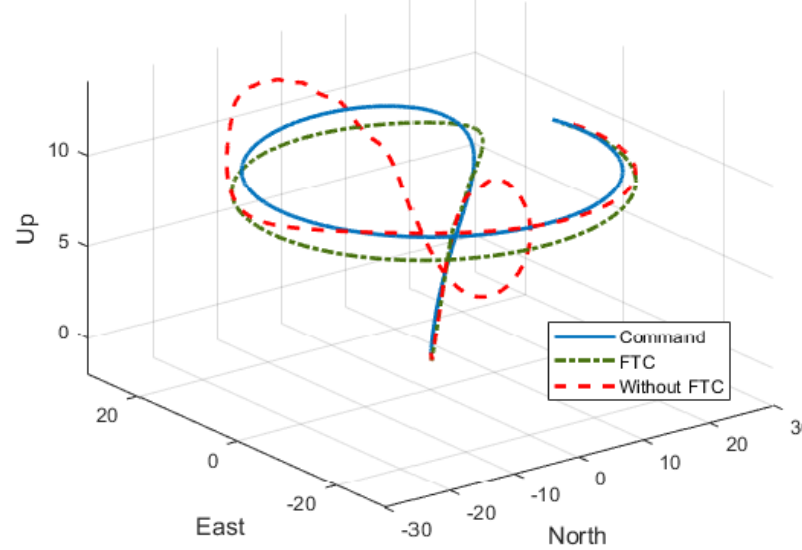
Figure 7. Trajectory tracking in the presence of abrupt fault (Figure